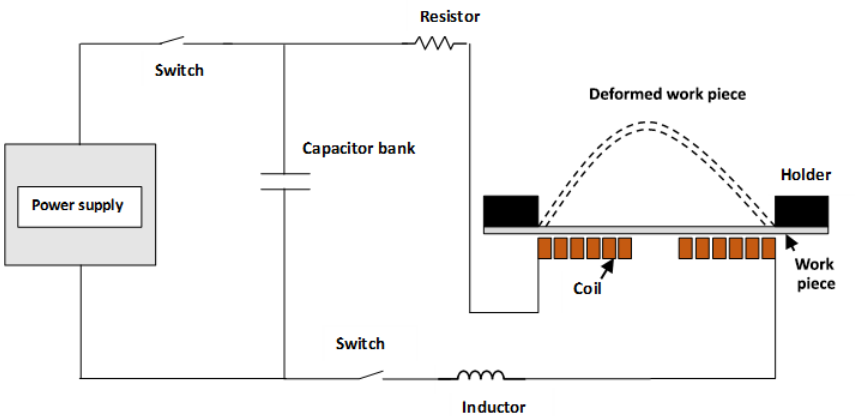
Figure 1. Schematic of the electromagnetic forming process for Al